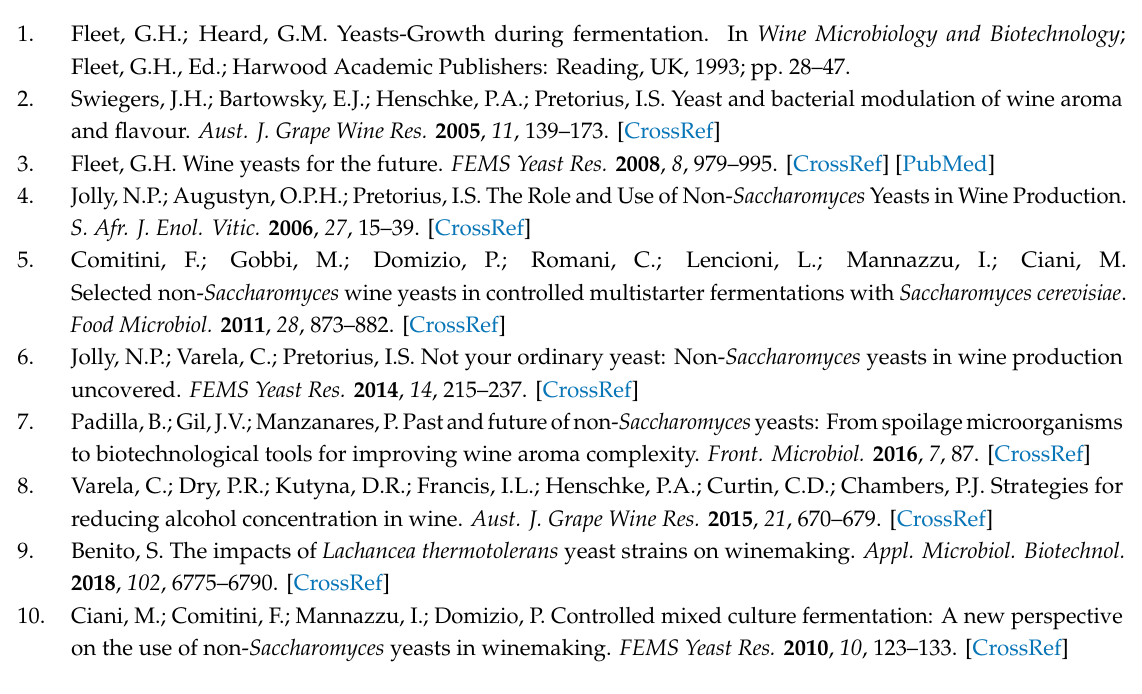
Table S1: Odor activity values (OAV) of volatile compounds determined in Treixadura wines made with di ff erent yeast strains; Table S2: Odor activity values (OAV) of volatile compounds determined in Menc í a wines elaborated with di ff erent yeast